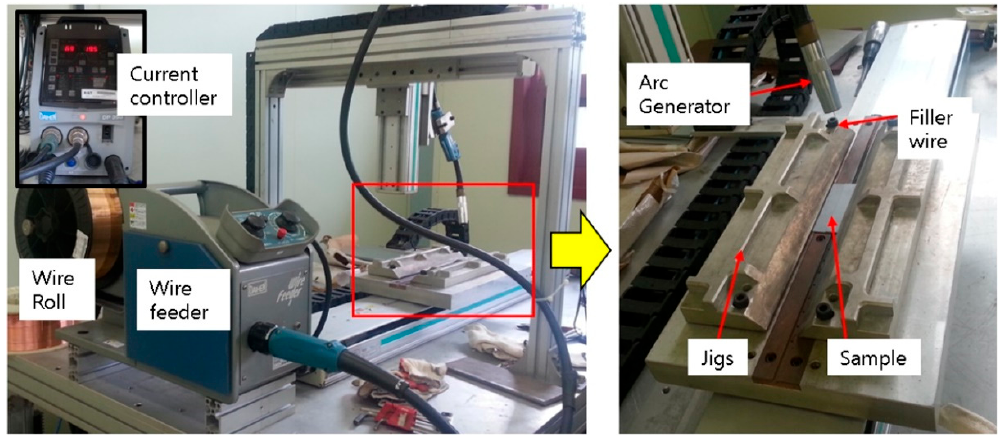
Figure 1. Arc brazing equipment and setup.